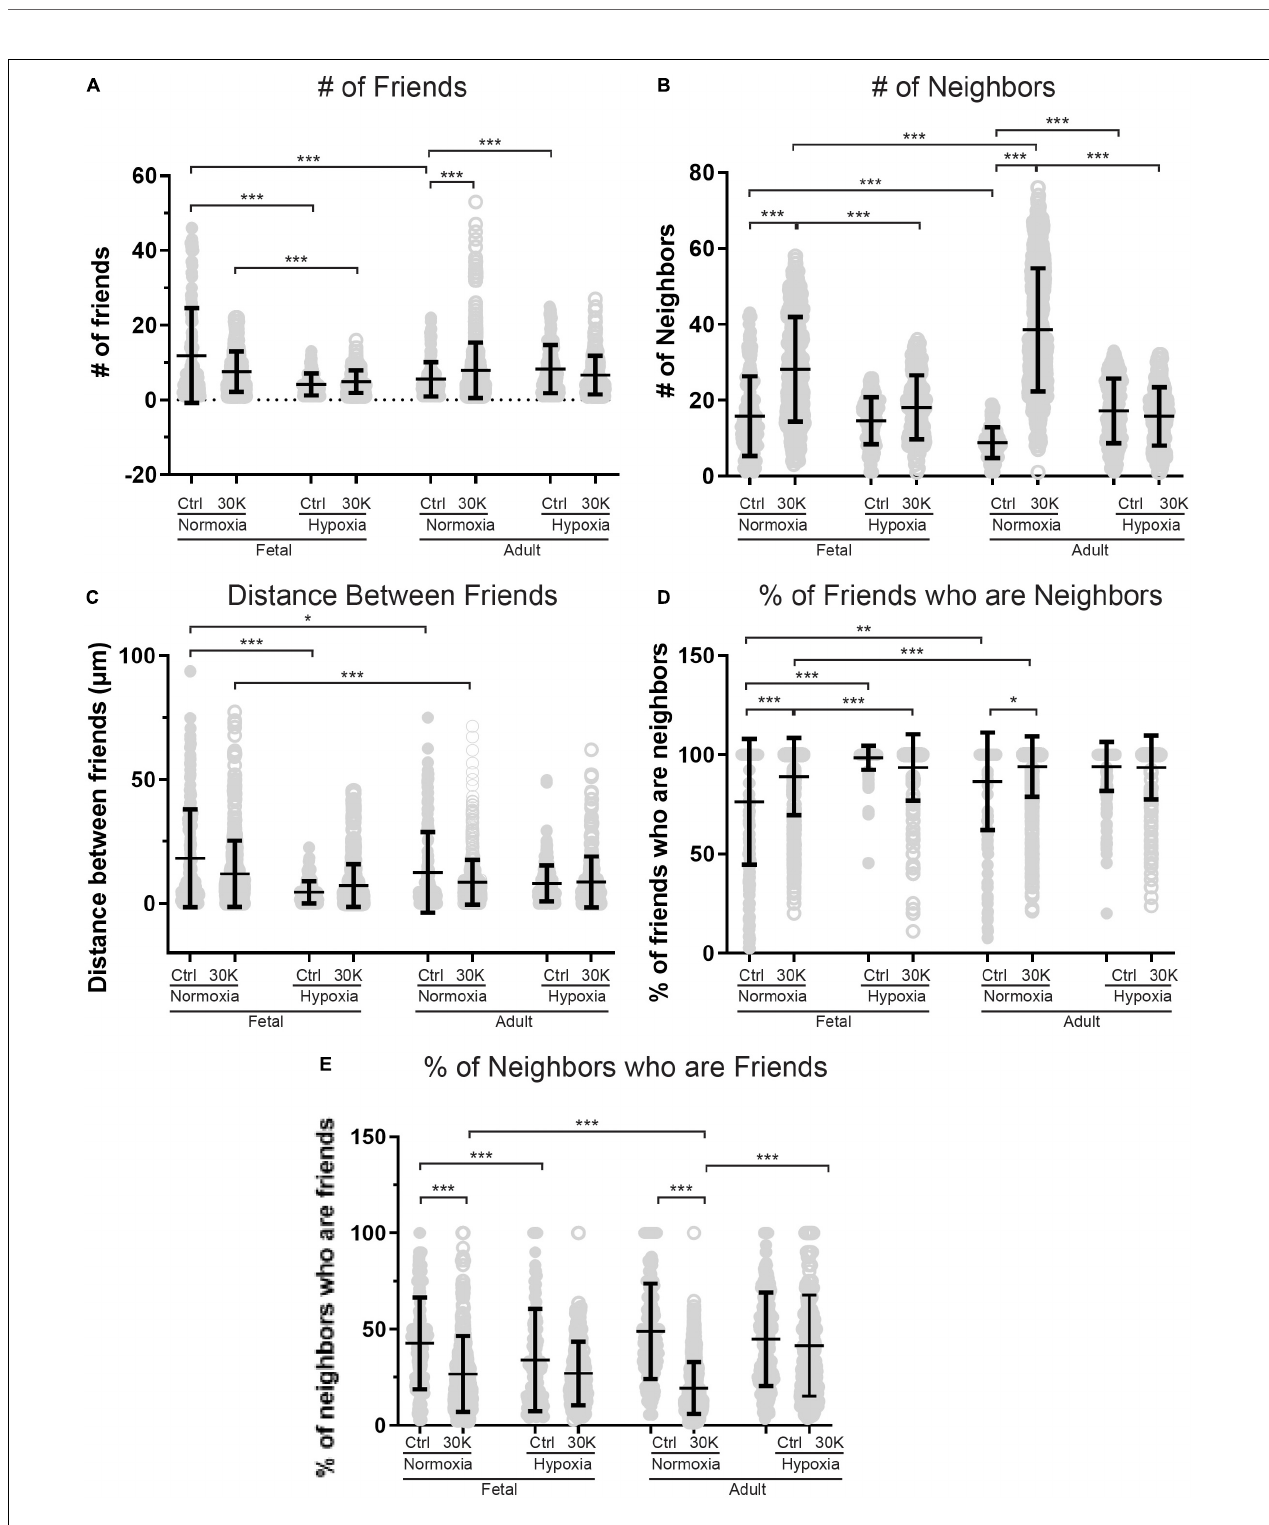
FIGURE 7 | Long-term hypoxia mitigates the influence of 30K mediated membrane depolarization on friends and neighbors. (A–E) Arteries were analyzed for number of correlated ROIs (friends), distance between correlated ROIs, percentage of nearby ROIs (neighbors) that were correlated, and percentage of correlated ROIs that were in nearby cells. Bars represent mean ± SD for each condition; closed circles specify control conditions, and open circles treatment with 30K. * P < 0.05, ** P < 0.01, *** P < 0.001 indicate significance based on based on a Kruskal–Wallis ANOVA with a Dunn’s multiple comparisons test based on ranks. Control responses were obtained from 178/3 AN, 235/4 AH, 175/3 FN, and 163/4 FH ROIs and animals, respectively. 30K responses were obtained from 844/3 AN, 244/4 AH, 537/3 FN, and 303/4 FH ROIs and animals, respectively.